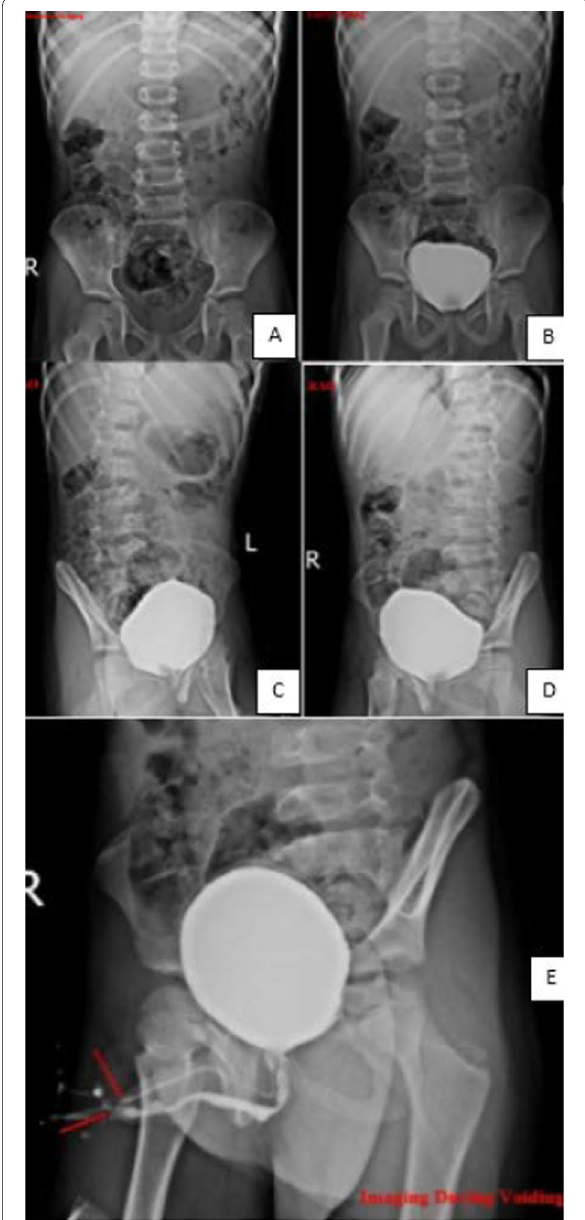
Fig. 1 VCUG of presented case. “ A ” is preliminary imaging, “ B ” is early filling image, “ C ” is left anterior oblique view(LAO) image, “ D ” is right anterior oblique view(RAO) image and “ E ” is voiding phase image. Dashed arrow (upper) shows distal opening of accessory urethra and solid arrow (lower) shows distal opening of main urethra. As shown in picture “ E ” there are two urethras arising from bladder with different proximal and distal